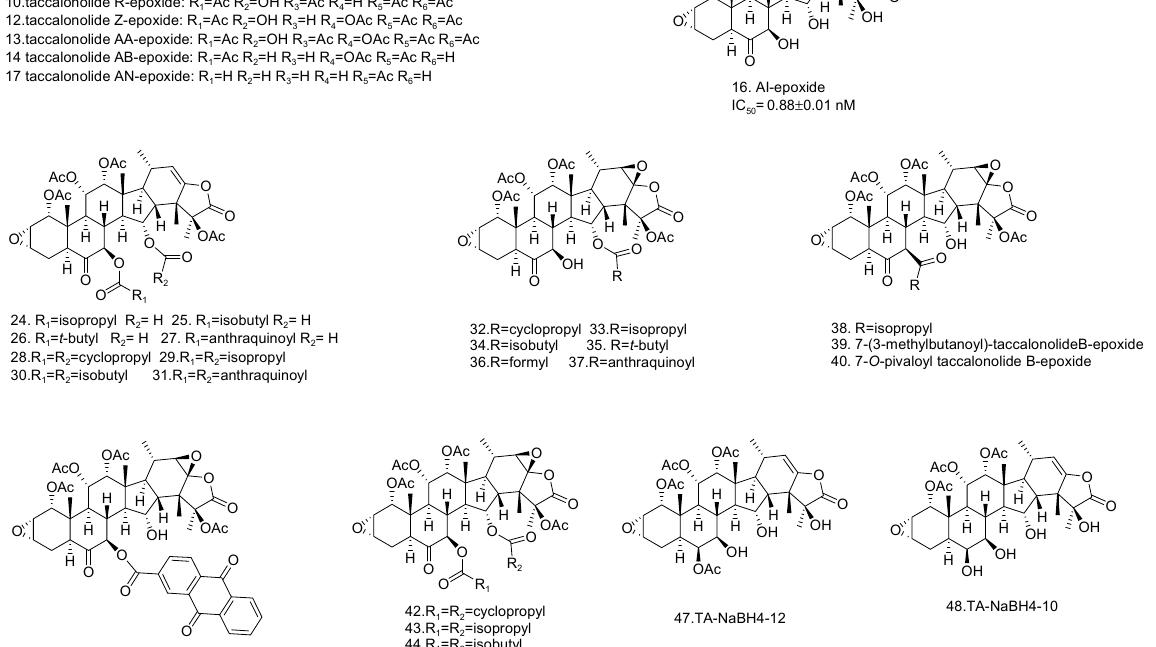
8.taccalonolide E-eposide: R 1 =Ac R 2 =H R 3 =H R 4 =H R 5 =Ac R 6 =Ac 9.taccalonolide N-epoxide: R 1 =Ac R 2 =H R 3 =H R 4 =H R 5 =Ac R 6 =H